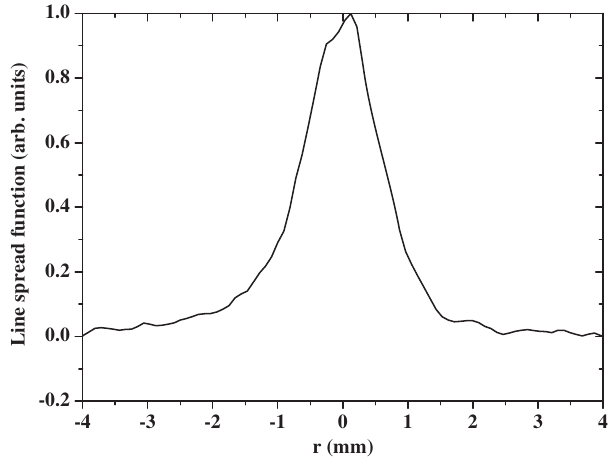
FIG. 15. Normalized LSF of the X-ray source. The spot size is defined as the FWHM of the LSF